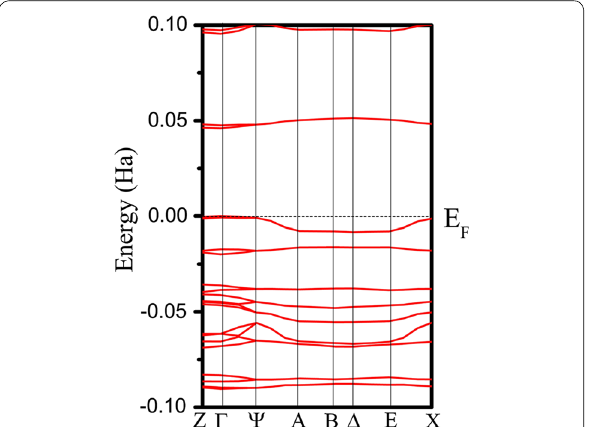
Fig. 3 DIP crystal band structures along the high‑symmetry points in Brillouin zone